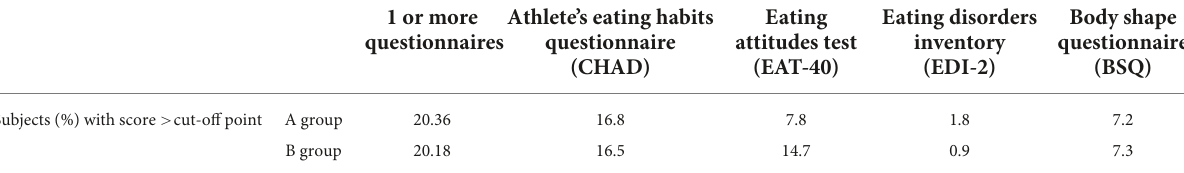
TABLE 4 Participants diagnosed with a particular EDs risk questionnaire and the prevalence detected with other EDs risk questionnaires among Spanish team sports players (A group, N = 167) and athletes playing ED high-risk sports (B group, N =